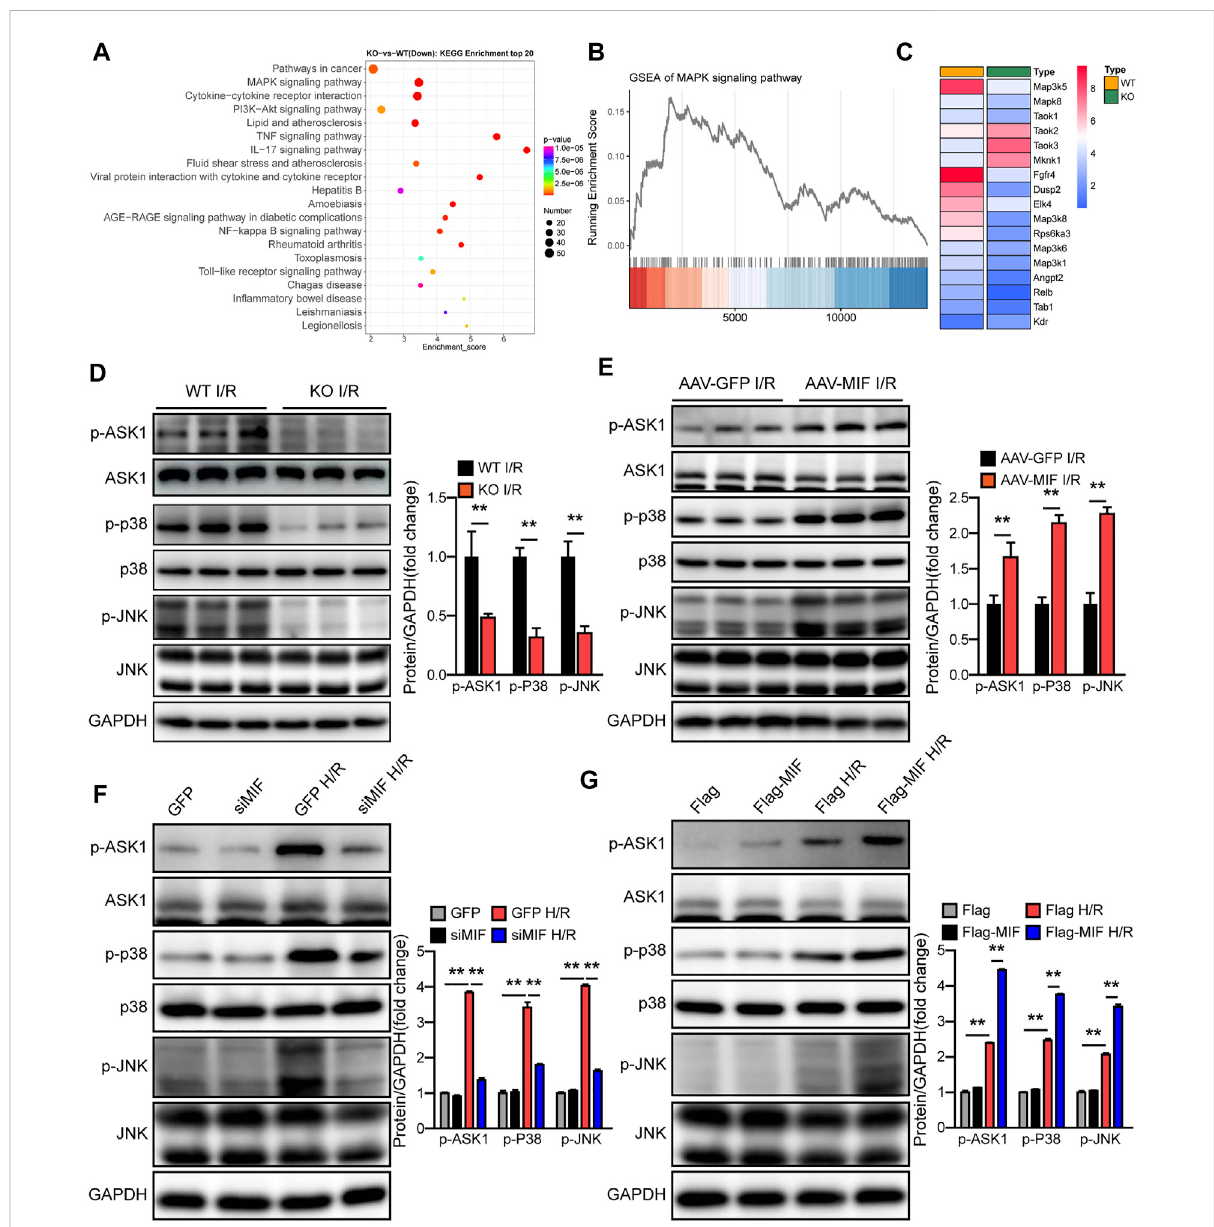
FIGURE 7 MIF activates the ASK1-JNK/p38 signaling during hepatic I/R injury. (A) KEGG pathway enrichment analysis of the major biological pathways contributing to MIF function. (B) GSEA-enriched analysis of MAPK pathways. (C) Heatmap showing expression of genes involved in MAPK pathways. (D) ProteinlevelsofthetotalandphosphorylatedproteinexpressionlevelsofASK1,P38,andJNKintheliverofMIF-KOandWTmiceafterhepaticI/R operation. GAPDH servedastheloadingcontrol( n =3pergroup). (E) Proteinlevelsofthetotalandphosphorylatedproteinexpressionlevels of ASK1, P38, and JNK in the liver of AAV-GFP and AAV-MIF mice after hepatic I/R operation mice. GAPDH served as the loading control ( n = 3 per group). (F) Protein levels of the total and phosphorylated protein expression levels of ASK1, P38, and JNK in GFP and siMIF hepatocytes that were challenged by H/R insult. GAPDH served as the loading control. Representative of three independent experiments. (G) Protein levels of the total and phosphorylatedproteinexpression levels ofASK1,P38,and JNKinFlagand Flag-MIF hepatocytes that werechallengedbyH/R